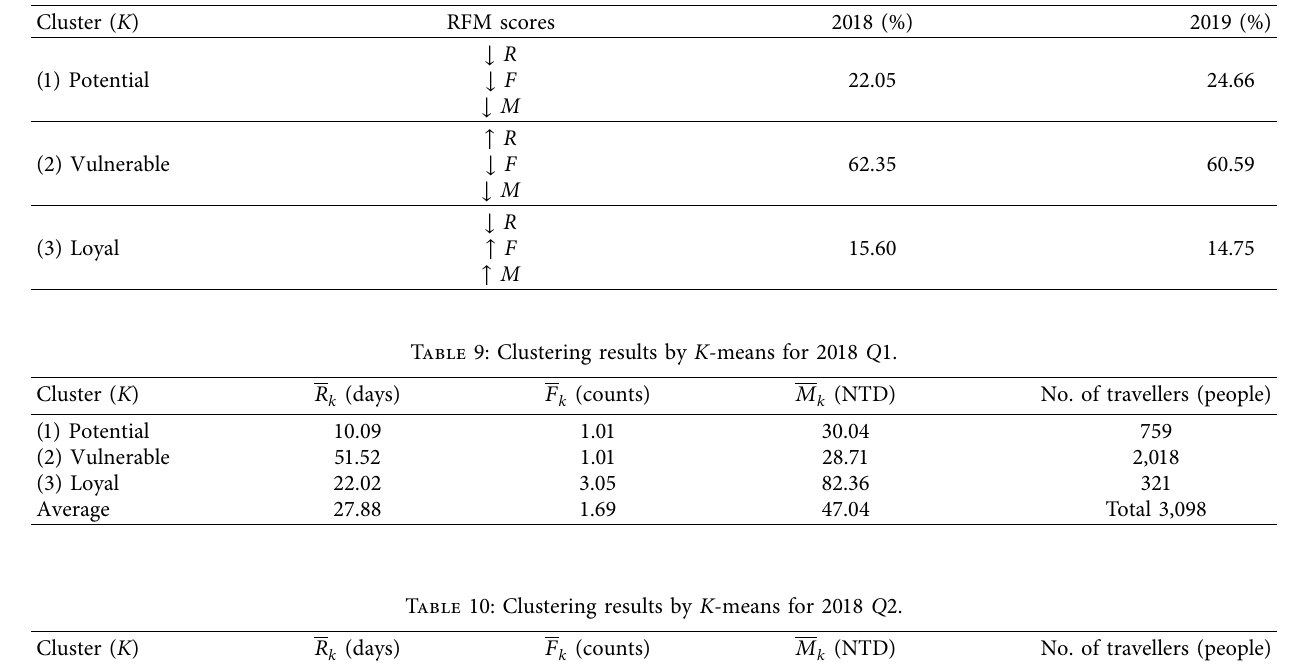
Table 8: Profiles of transit travellers in 2018 and 2019.